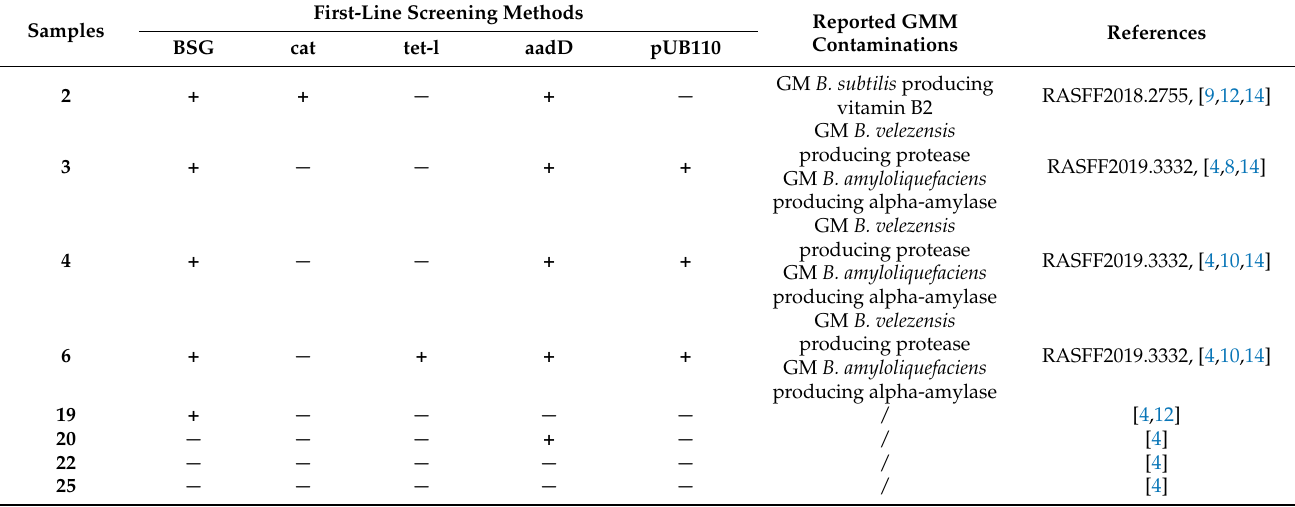
First-Line Screening